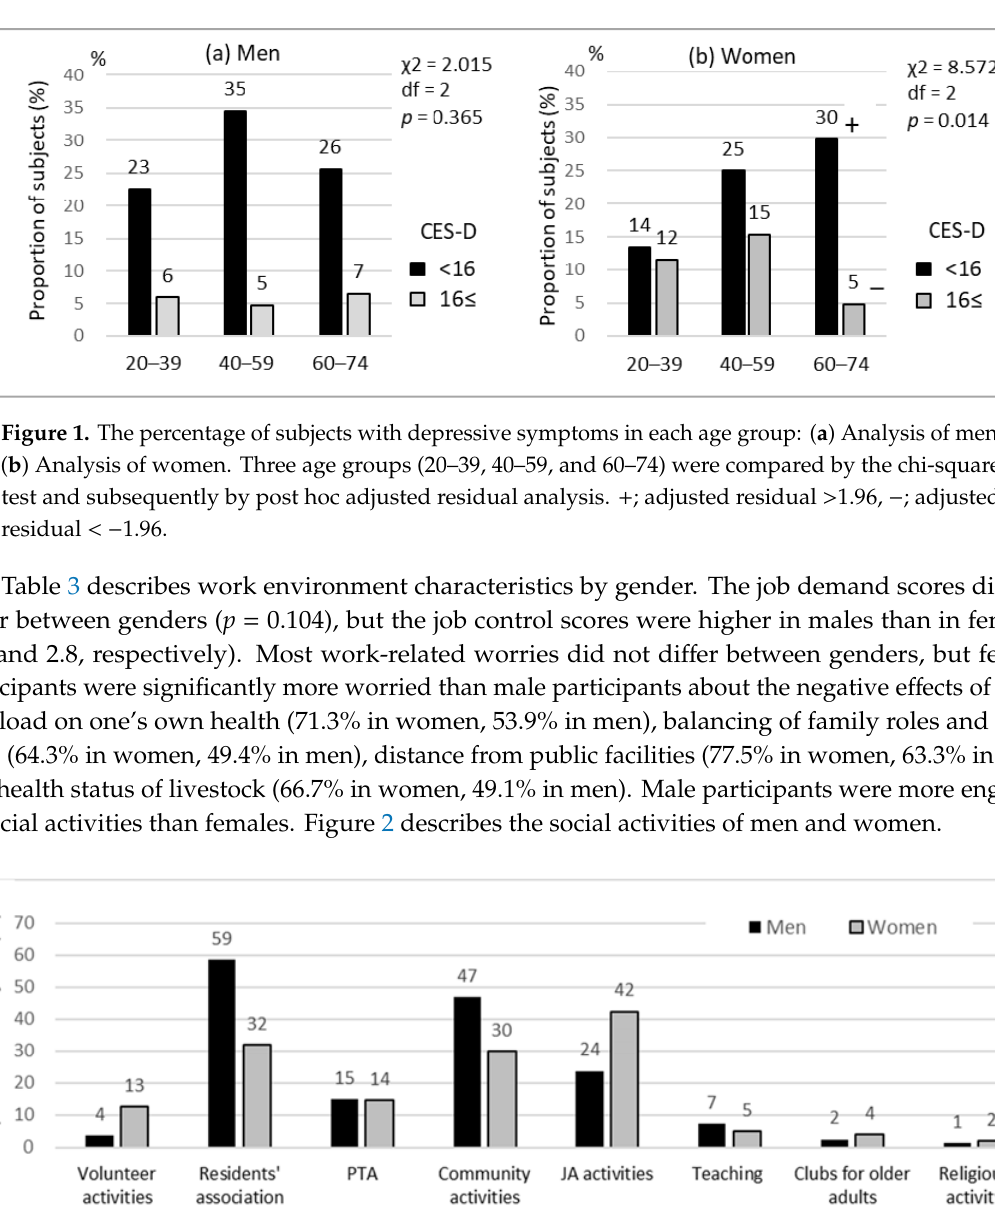
Figure 2. The percentage of the subjects who participated in men’s and women’s social activities. PTA = Parent Teachers Association; JA = Japan Agricultural Cooperative